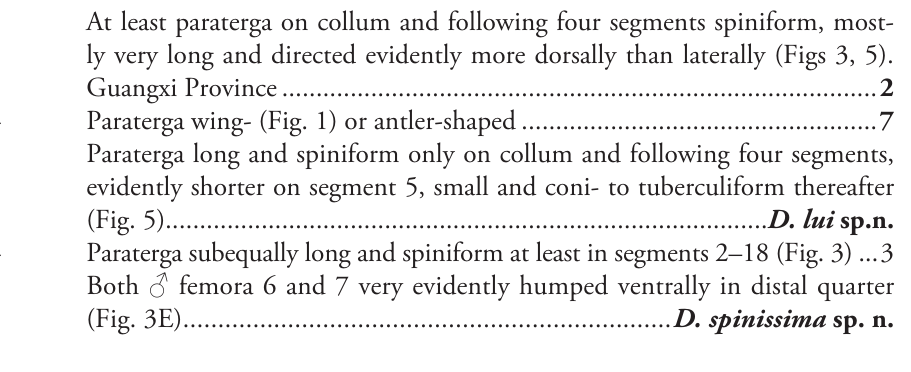
Figure 6. Desmoxytes lui sp. n., ♂ holotype. A sternal cones between coxae 4, ventral view B–D right go- nopod telopodite, mesal, dorsal and sublateral views, respectively. Scale bar: 1.0 ( A ) and 0.5 mm ( B–D ). Designations: fe femorite sph solenophore sl solenomere ll lamina lateralis lm lamina